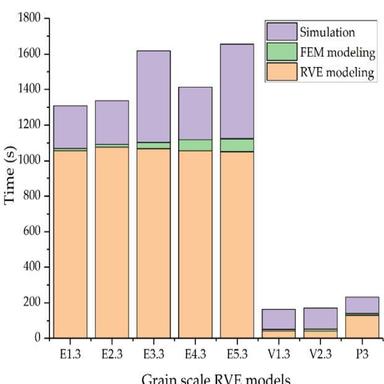
Computational cost comparisons of different grain scale RVE models.